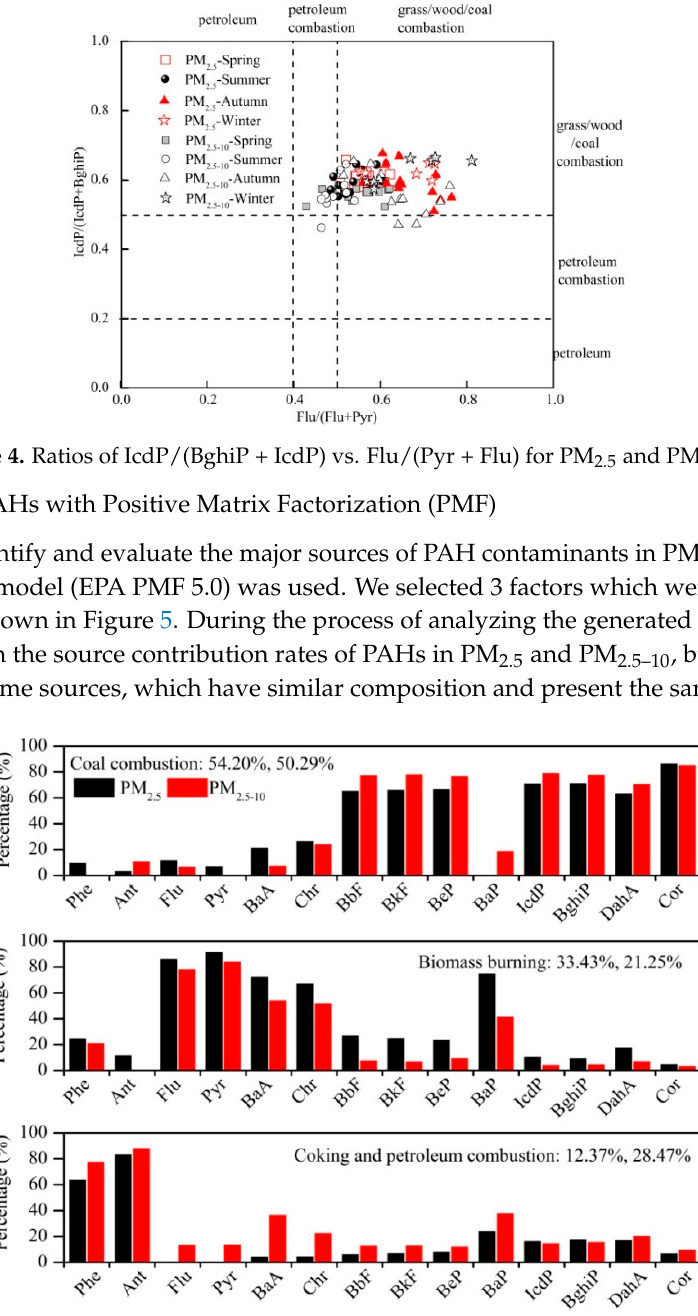
Figure 5. Factor profiles (% of total) of PM 2.5 , PM 2.5–10 obtained from the EPA PMF model.